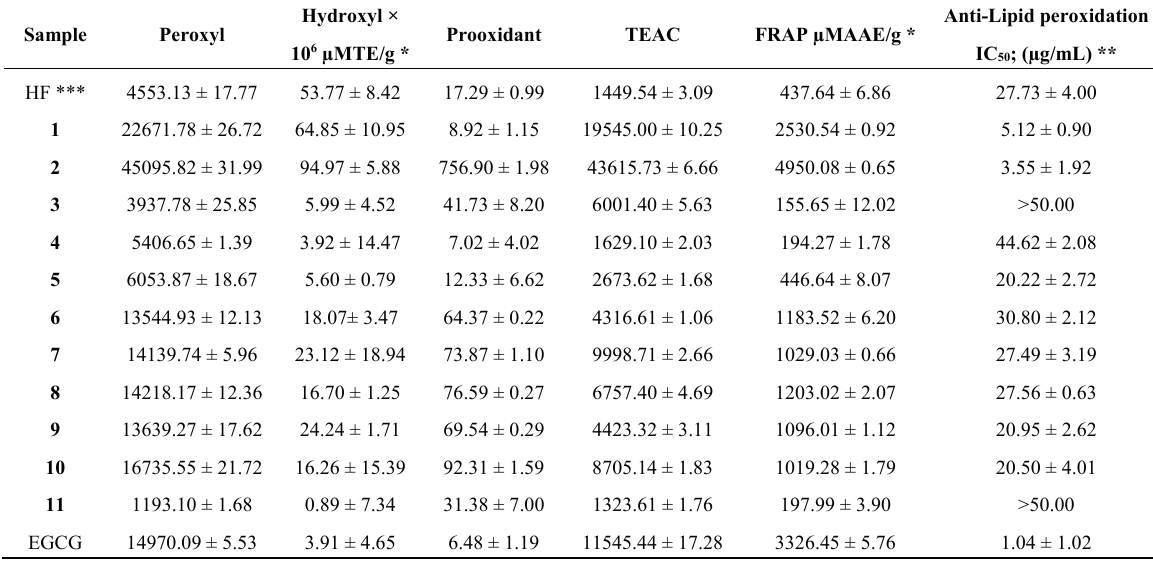
* Data expressed as ± % STDEV; ** Data are given as IC 50 ± STDEV with tested samples screened